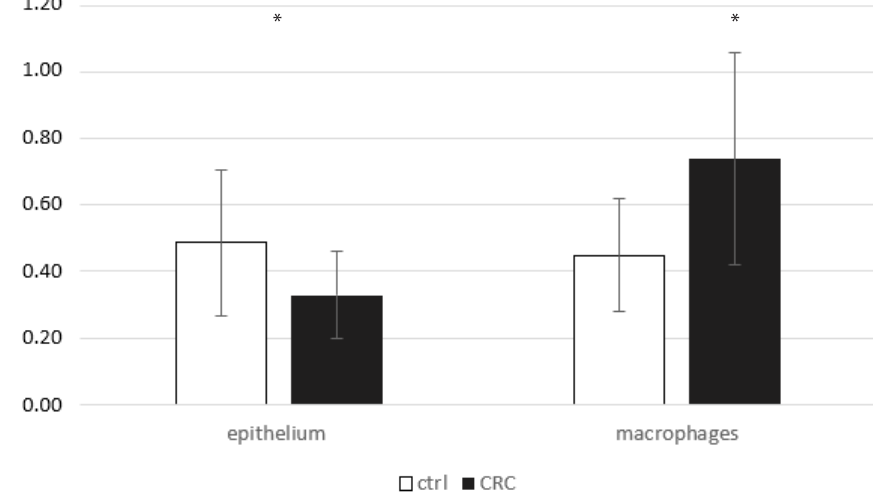
Fig. 3. Expression of MMP-19 in epithelium and macrophages. Compared CRC group to controls; 58 samples of CRC and 33 control samples were included; * P <0.05 (Mann-Whitney